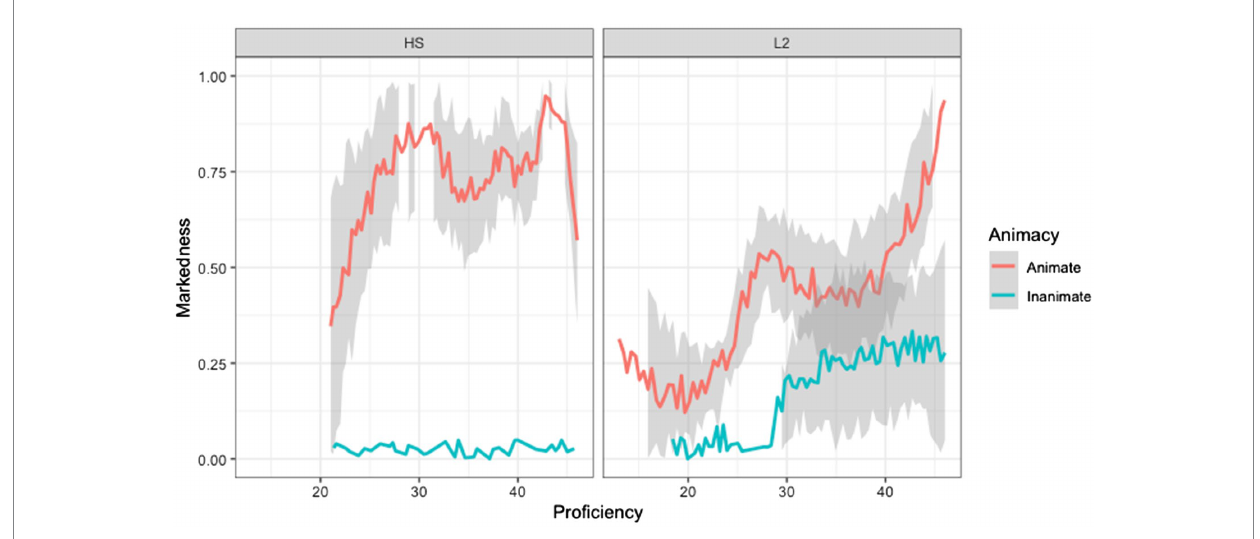
FIGURE 3 The effect of proficiency on the production of DOM (narrative).